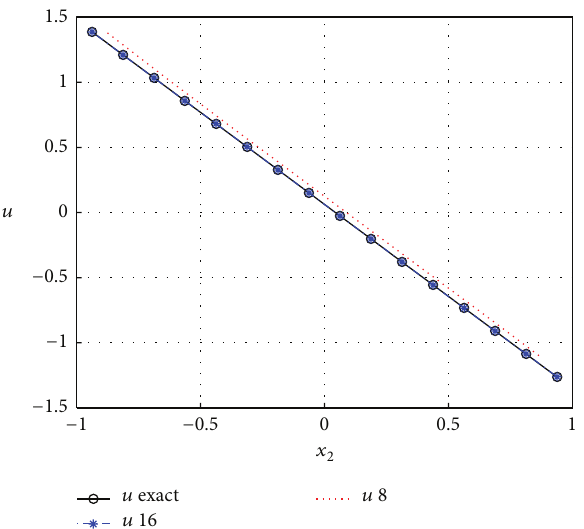
Figure 3: Optimal feedback control for Example 2 via the SHWCM with 𝑚 = 8, 16, 32 and 𝑥 1 = −0.1250, −0.0625, −0.0313 , respectively.